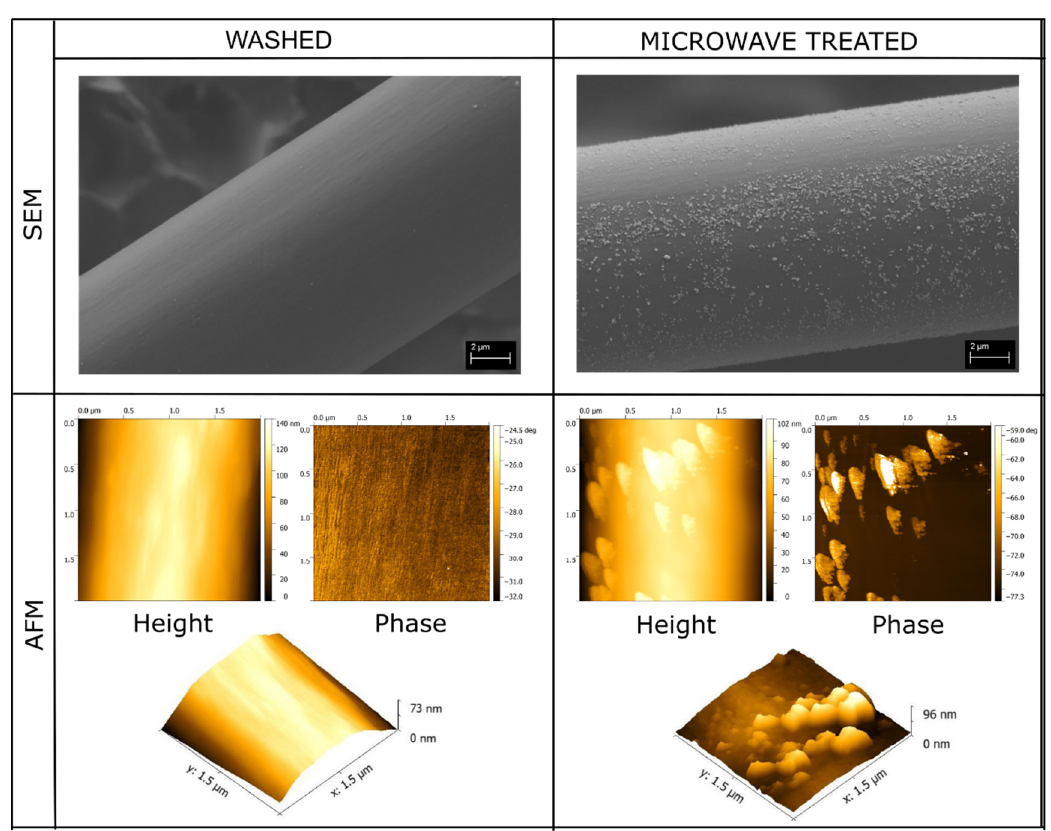
Figure 1. SEM images and corresponding AFM images of the aramid fibers before and after the microwave surface treatment.